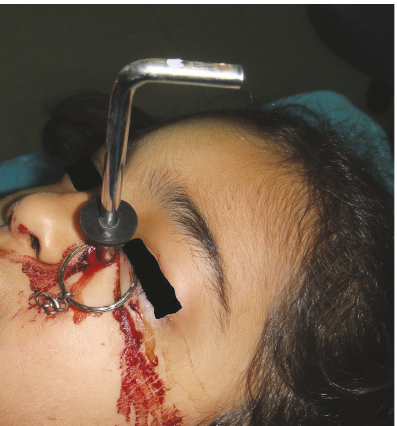
Figure 1: Photograph of the patient at the time of admission.